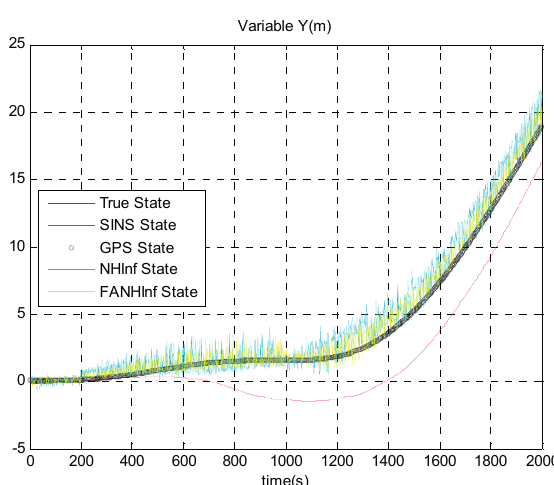
Figure 5. Estimation of the position Y .